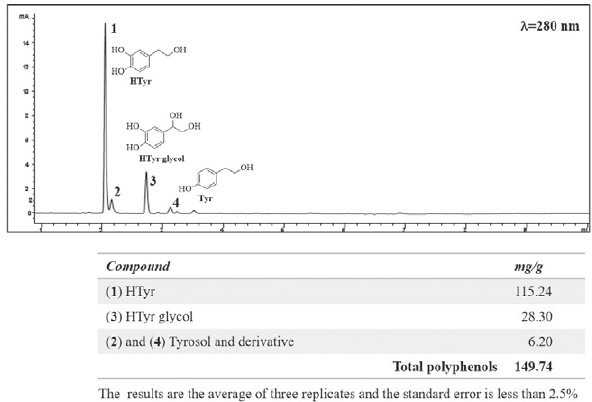
Figure 1. HPLC/DAD chromatographic profi le of HTE2 at 280 nm.